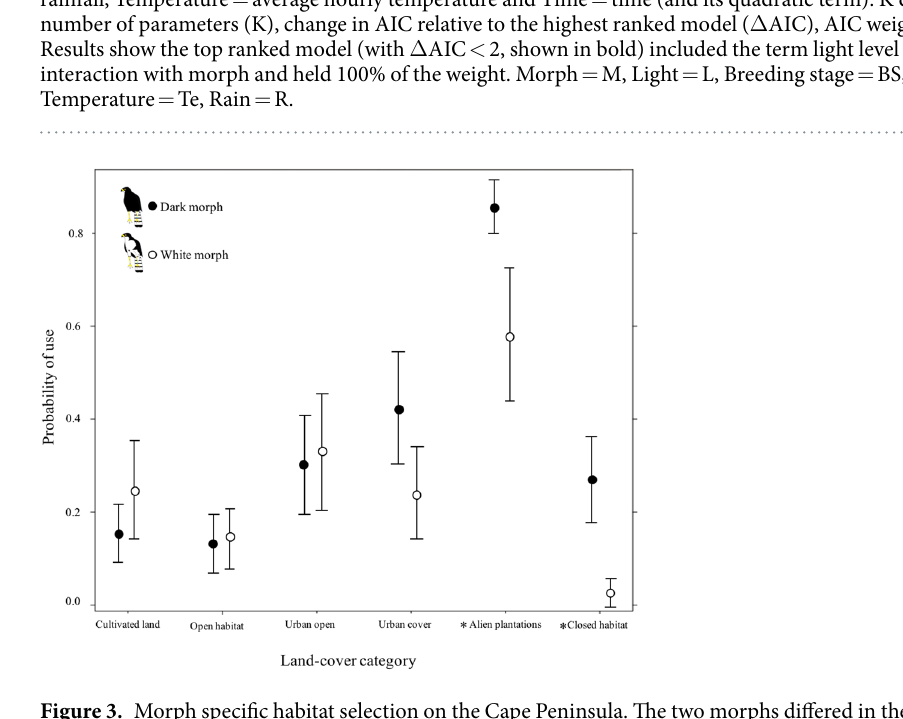
Figure 3. Morph specific habitat selection on the Cape Peninsula. The two morphs differed in their level of habitat selection; with no obvious difference in selection between the morphs for the more open habitats of ‘urban open’ (Lsmeans pairwise test, P = 0.9), ‘cultivated land’ (Lsmeans pairwise test, P = 0.8) and ‘open habitat’ (Lsmeans pairwise test, P = 1) than dark morphs. Conversely, dark morphs showed significantly greater selection for the more closed ‘alien plantations’ (Lsmeans pairwise test, P < 0.001) and ‘closed habitat’ (Lsmeans pairwise test, P < 0.001) than white morphs. Morphs had a similar selection for the habitat ‘urban cover’ (Lsmeans pairwise test, P = 0.2). Bars indicate one standard